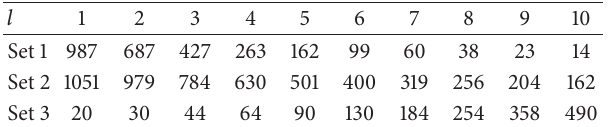
Table 4: Simulation